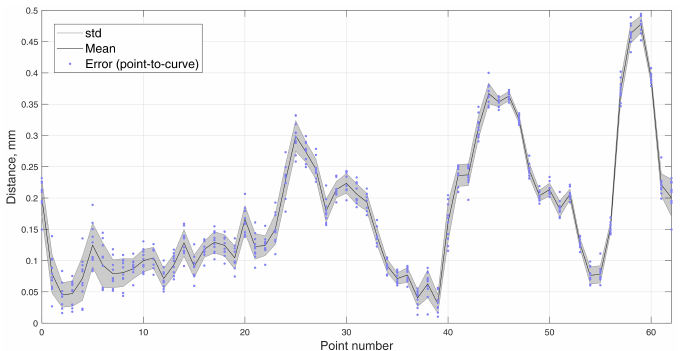
Figure 16. Error (point–to–curve) from the reference masticatory trajectory to the estimated trajectory in 10 iterations of the dynamic test, with the mean and standard